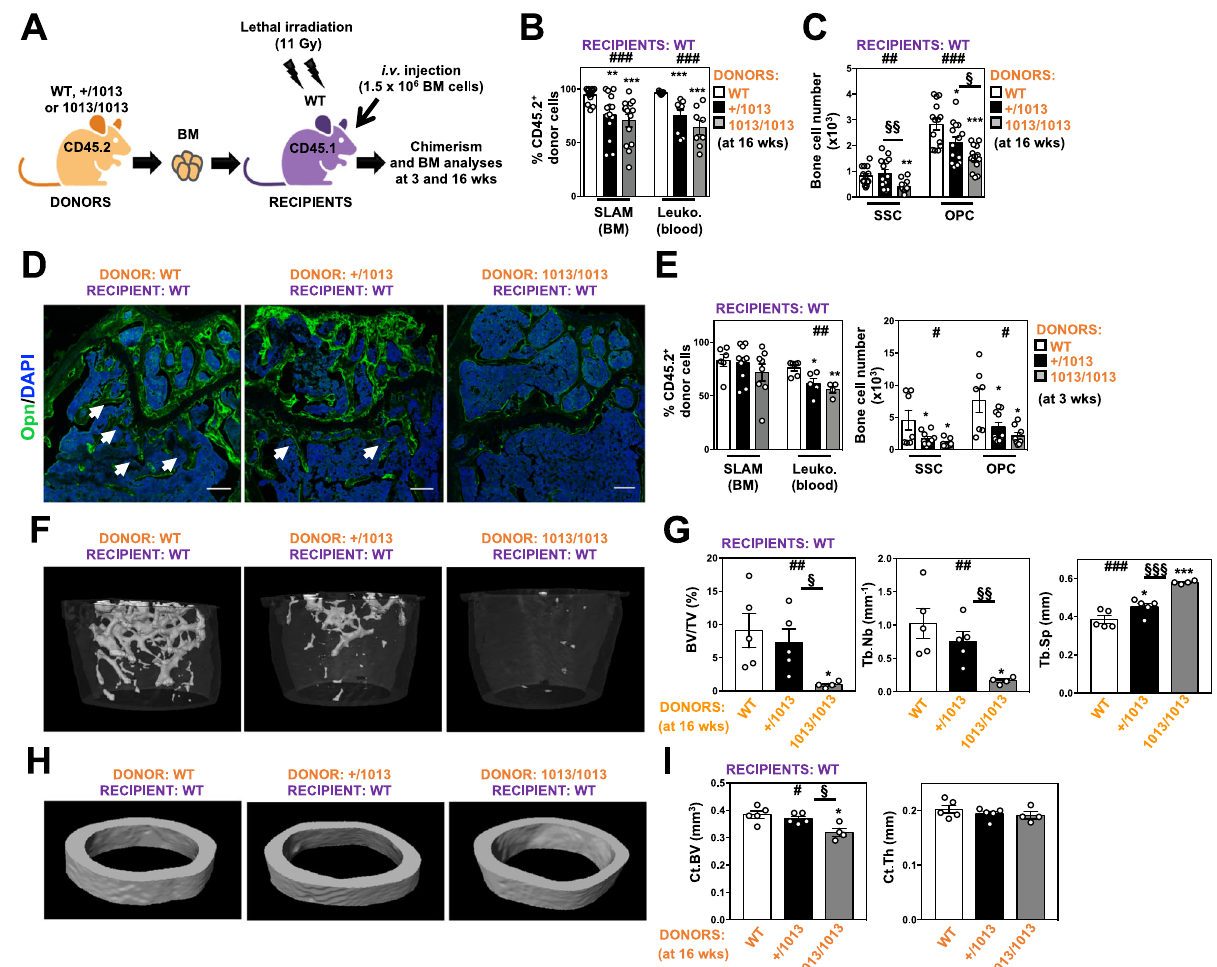
Fig. 3 | Cell-extrinsic Cxcr4-mediated regulation of the skeletal landscape. A Schematic diagram for the generation of CD45.2 → CD45.1 short (3 wks)- or long (16 wks)-term BM chimeras. Mouse icons were created using the Biorender soft- ware (Biorender.com, agreement number: VX255VH9TZ). B Proportions of WT or mutantdonorCD45.2 + LSKSLAMandleukocytesrecoveredfromtheBMandblood of BM chimeras in CD45.1 + WT recipients 16 weeks after transplantation. Statistics were calculated with the nonparametric Kruskal – Wallis H test ( ### p =0.0008 for (+/1013vsWT** p =0.0036,1013/1013vsWT*** p =0.0004,forSLAM;+/1013vsWT *** p =0.0003,1013/1013vs WT *** p <0.0001,for Leukocytes). C Absolute